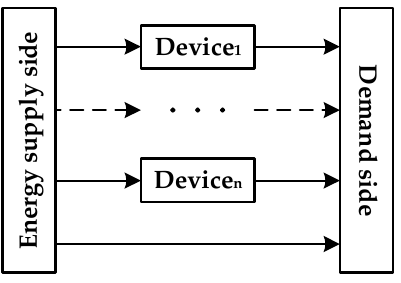
Figure 3. Simple energy-conversion interface (ECI) energy-flow diagram.